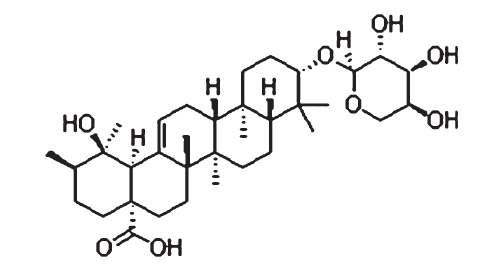
Figure 1. Chemical structure of ziyuglycoside